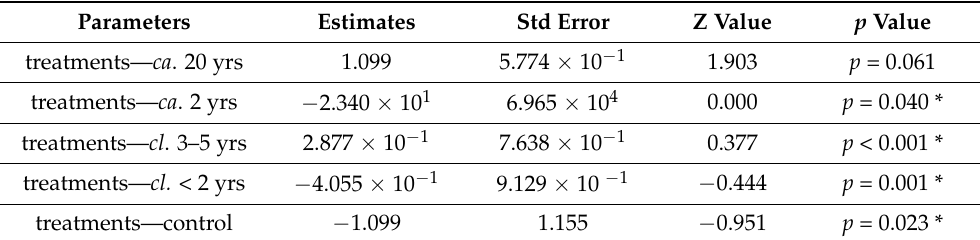
Table 5. The output of a GLMM model showing species richness by treatment types. Significant values are indicated by an asterisk.